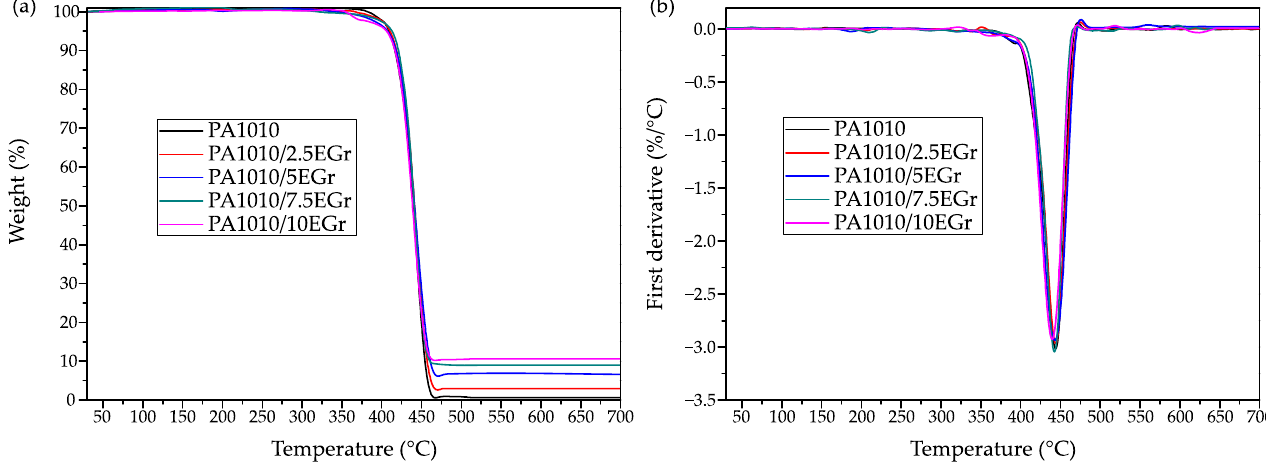
Figure 4. Thermal degradation of PA1010/EGr composites, ( a ) thermogravimetric (TGA) curves and ( b ) first derivative (DTG) curves. Table 4. Main thermal degradation parameters of the composites with different amounts of expand- able graphite in terms of: initial temperature of degradation at mass loss of 5% (T 5% ), maximum degradation rate temperature (T deg ) and residual mass at 700 ◦